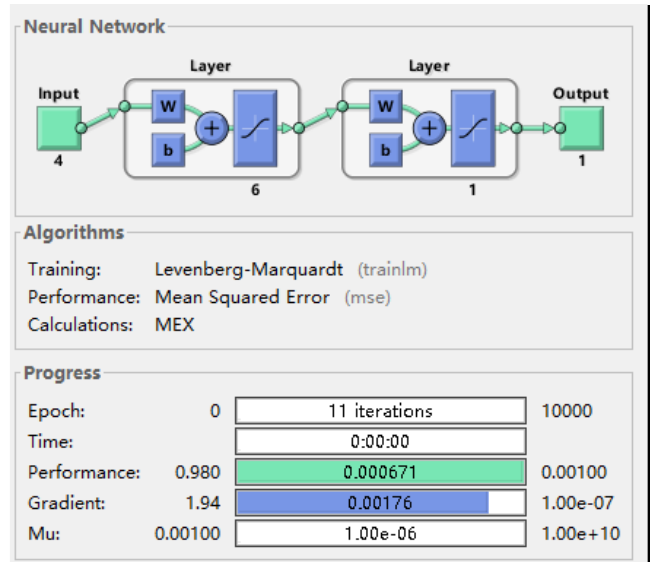
Figure 13. BP neural network training parameter diagram.